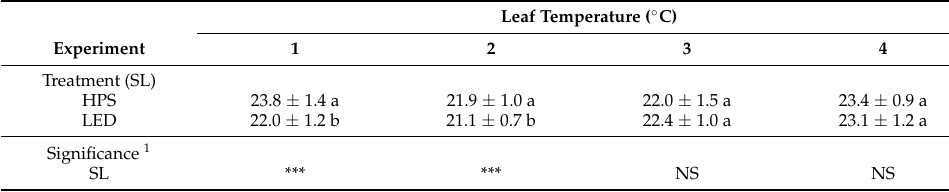
Table 3. Leaf temperature ± SE ( ◦ C) in seven tomato genotypes grown under HPS and LED supple- mental light, in four experiments differing in fraction of SL over natural light (treatments: n = 21; genotypes: n = 3). Significance was tested by two-way ANOVA. Means followed by different letters within a column indicate significant differences according to Fisher’s protected LSD test ( p = 0.05). SL—supplemental light treatments.